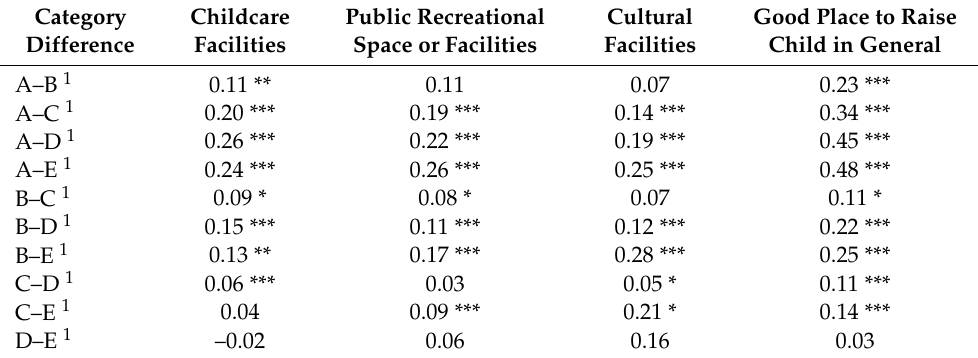
Table 3. Bonferroni Post Hoc Test